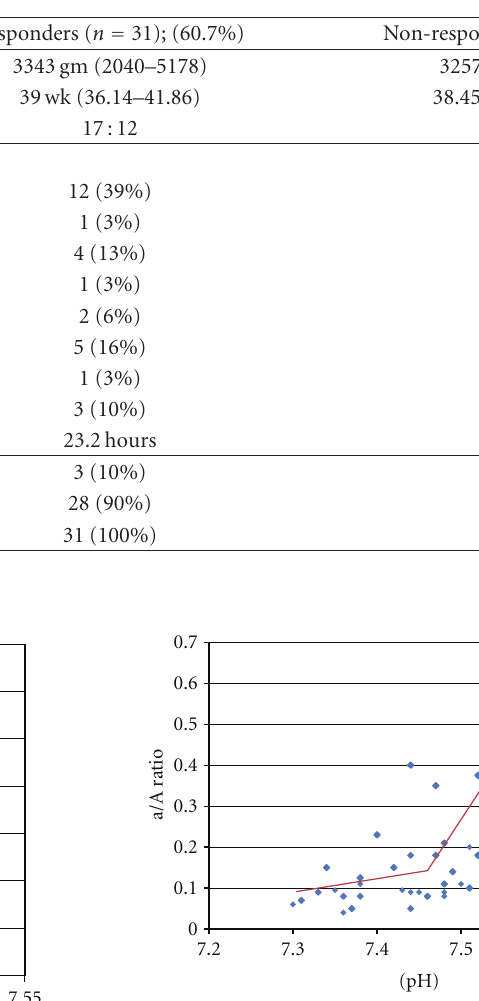
Table 1: Demographic data for study patients according to pH responsive status.